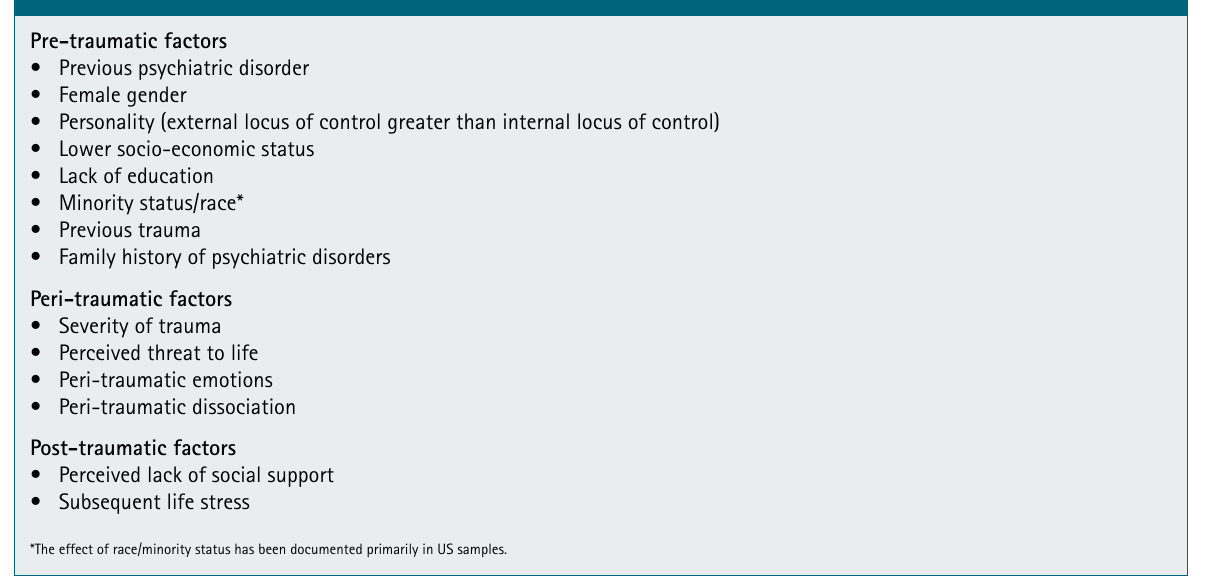
taBlE i. FactORs assOciatEd WitH tHE dEVElOpMEnt OF ptsd